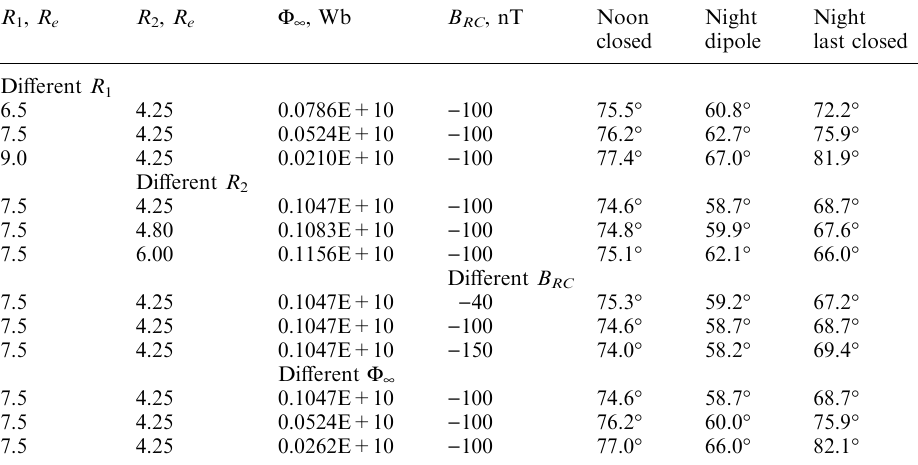
Table 1. The paraboloid model calculation results with the dif- ferent input